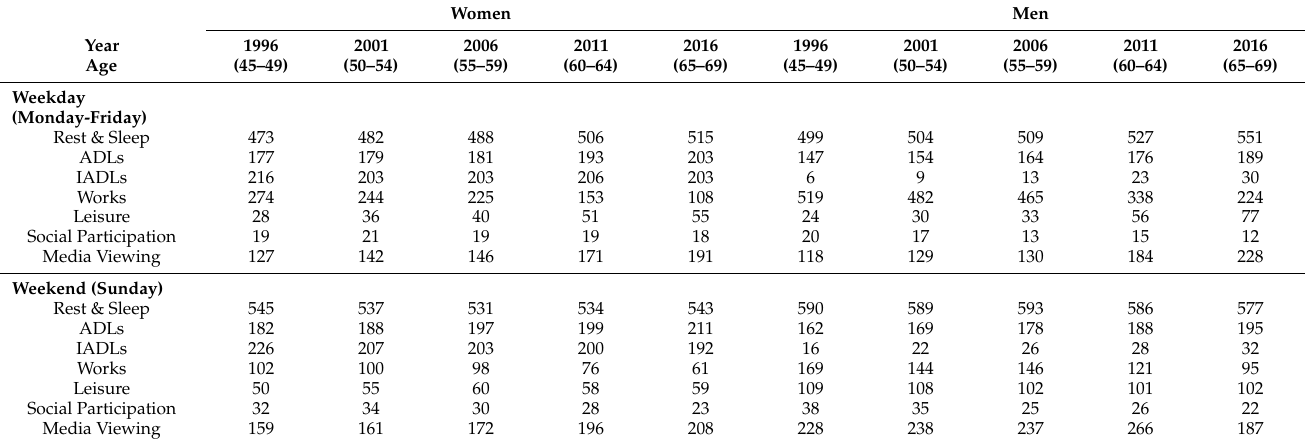
Table 1. Characteristics of time allocation for Japan’s baby boomers in every 5 years (1996–2016). Women